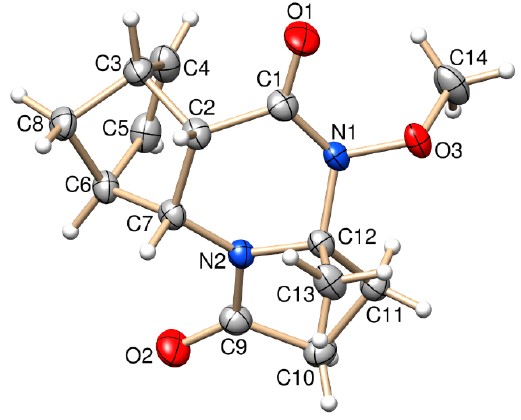
Figure 3. ORTEP plot of the X-ray structure of (±)- 6a .